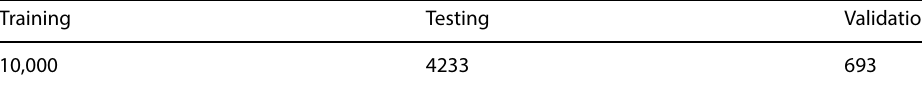
Table 2 Classification train- test split